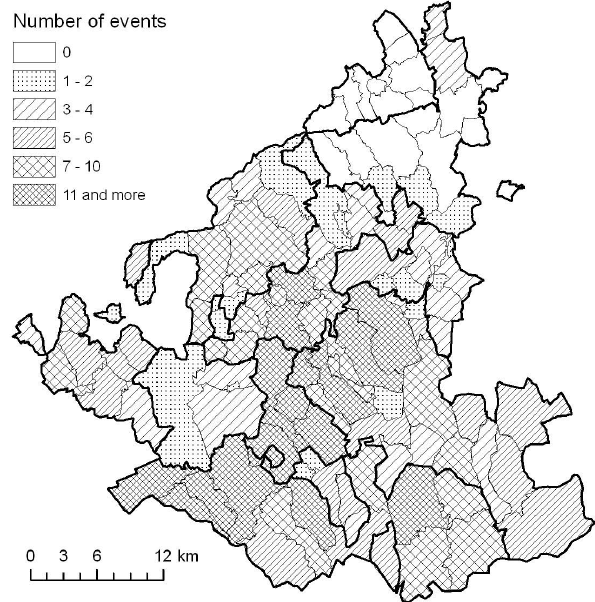
Fig. 4. Numbers of extreme hydrometeorological events recorded in south-eastern Moravia in the 1751–1900 period (numbers are re- lated to the land registers of individual